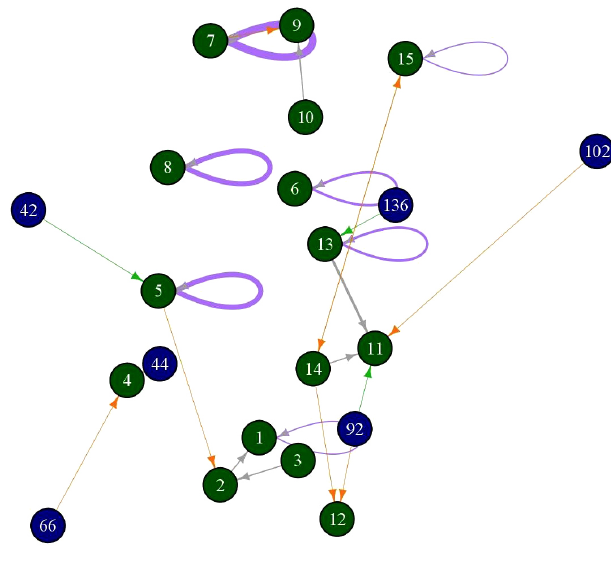
Fig. 6 . The network of repeated transactions from 2010 to 2011. The green nodes represent the interviewed seed recipients and the blue ones are the providers. The colors of the edges distinguish seed acquisitions between members of the same household (loops), neighbors (in orange), mothers and their daughters (in green), and other partners (in grey). The width of an edge represents the number of seed acquisition events (ranging from 1 to